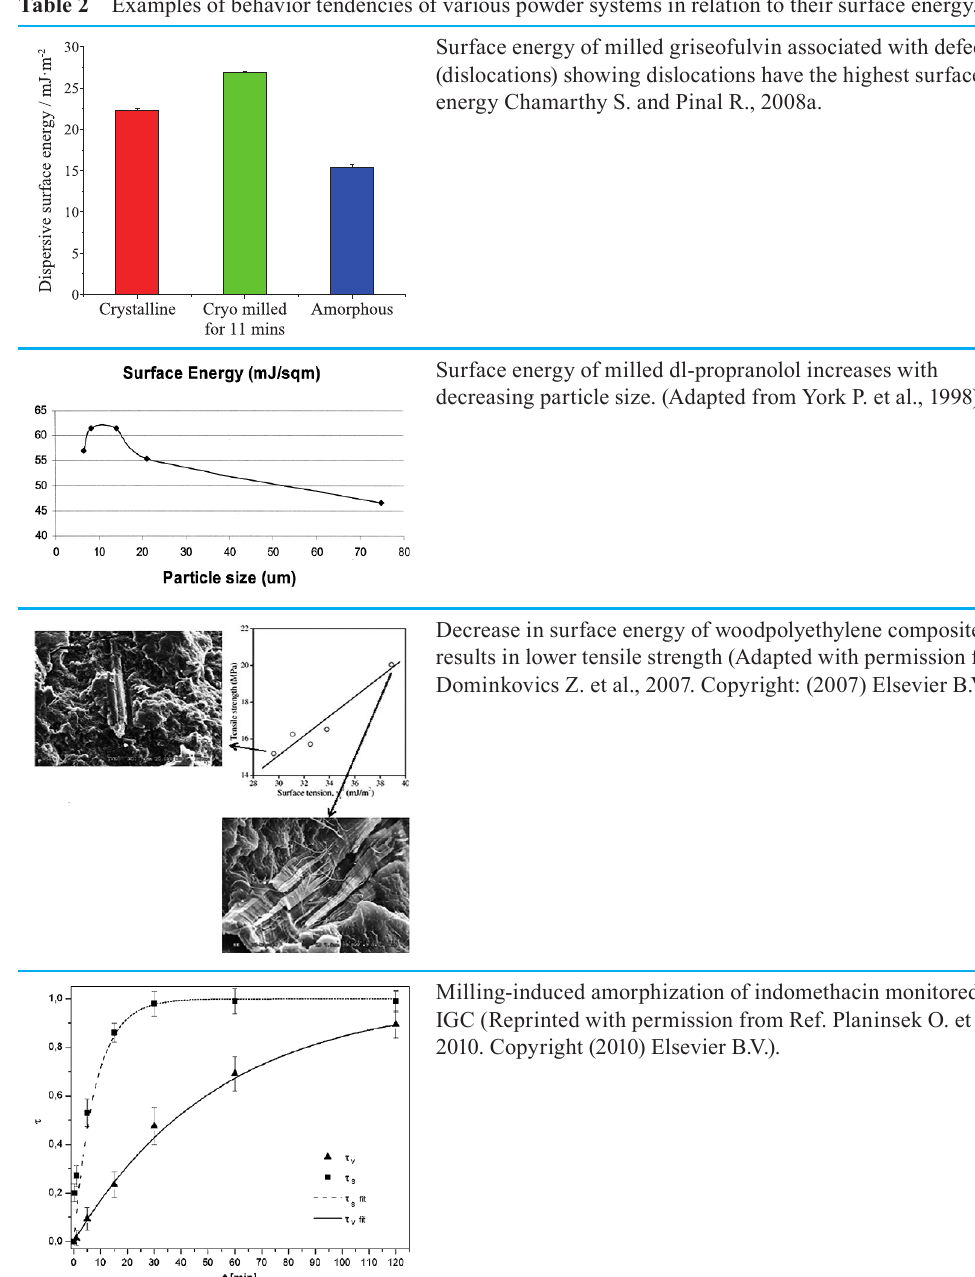
Table 2 Examples of behavior tendencies of various powder systems in relation to their surface energy. Surface energy of milled griseofulvin associated with defects (dislocations) showing dislocations have the highest surface energy Chamarthy S. and Pinal R.,